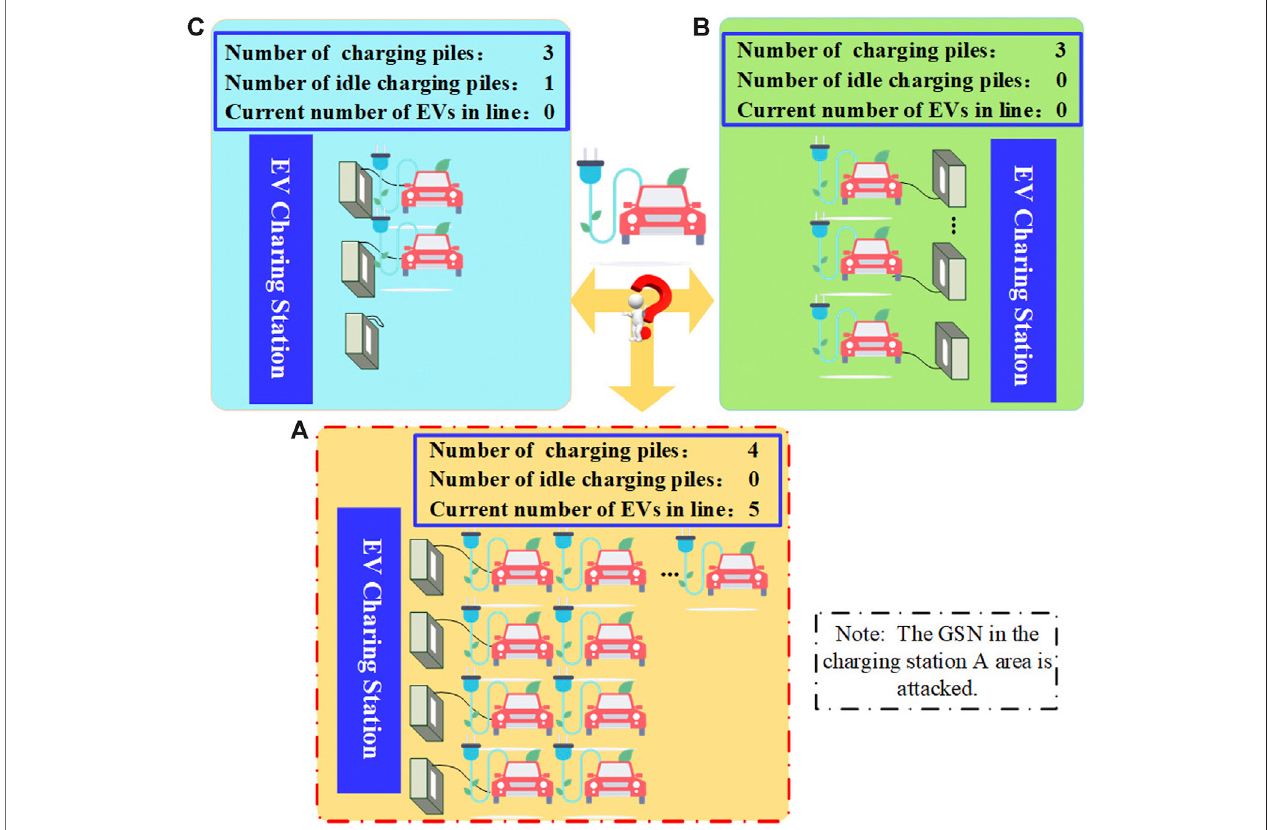
FIGURE 1 | Schematic diagram of the unbalanced charging